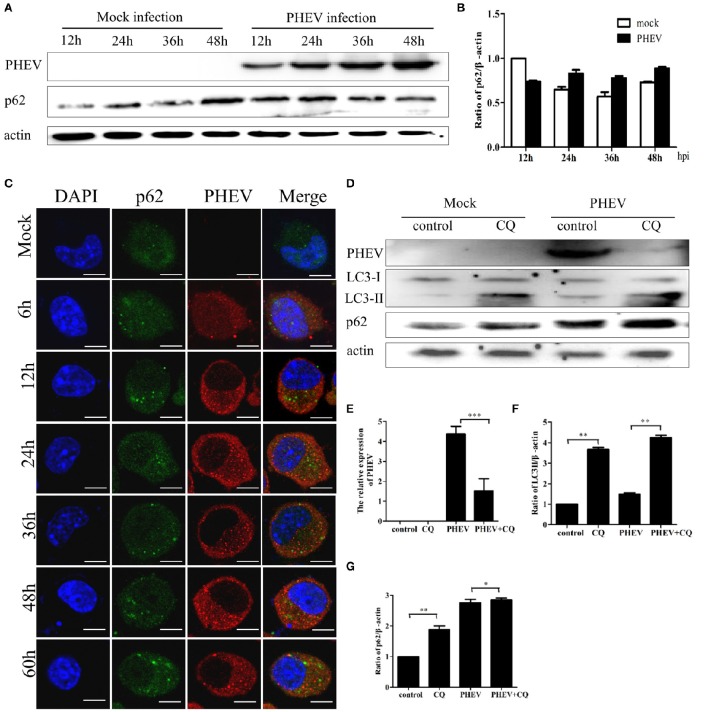
PHEV infection suppresses autophagic flux. (A) Western blot analysis of p62 changes in Neuro-2a cells with PHEV infection for 12, 24, 36, and 48 h, as well as the mock infection for the relevant times. (B) The p62 to β-actin ratio normalized to the mock infection set at 1.0 of (A) (n = 3; P < 0.05). (C) Representative images of Neuro-2a cells with PHEV infection from 6 to 60 h labeled with antibodies to anti-p62 and anti-PHEV. (D) Effect of chloroquine (CQ) treatment on LC3-II and p62 of Neuro-2a cells for 24 h, as tested by Western blotting. (E–G) show the ratios of PHEV to β-actin, p62 to β-actin or LC3-II to β-actin from three independent experiments of (D). *P < 0.05; **P < 0.01; ***P < 0.001. Scale bars: 10 μm.